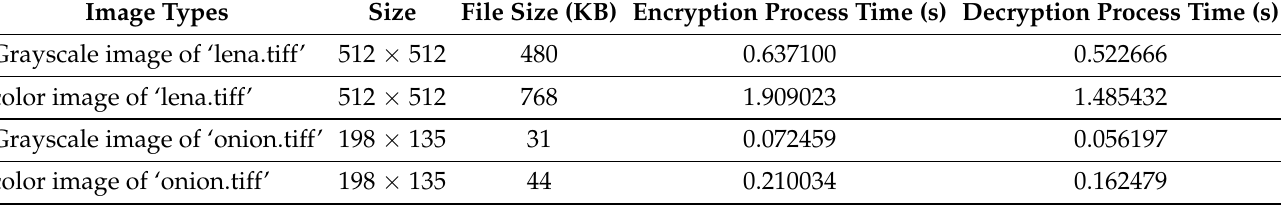
Table 3. Analysis of the execution efficiency of encryption and decryption algorithms. Image